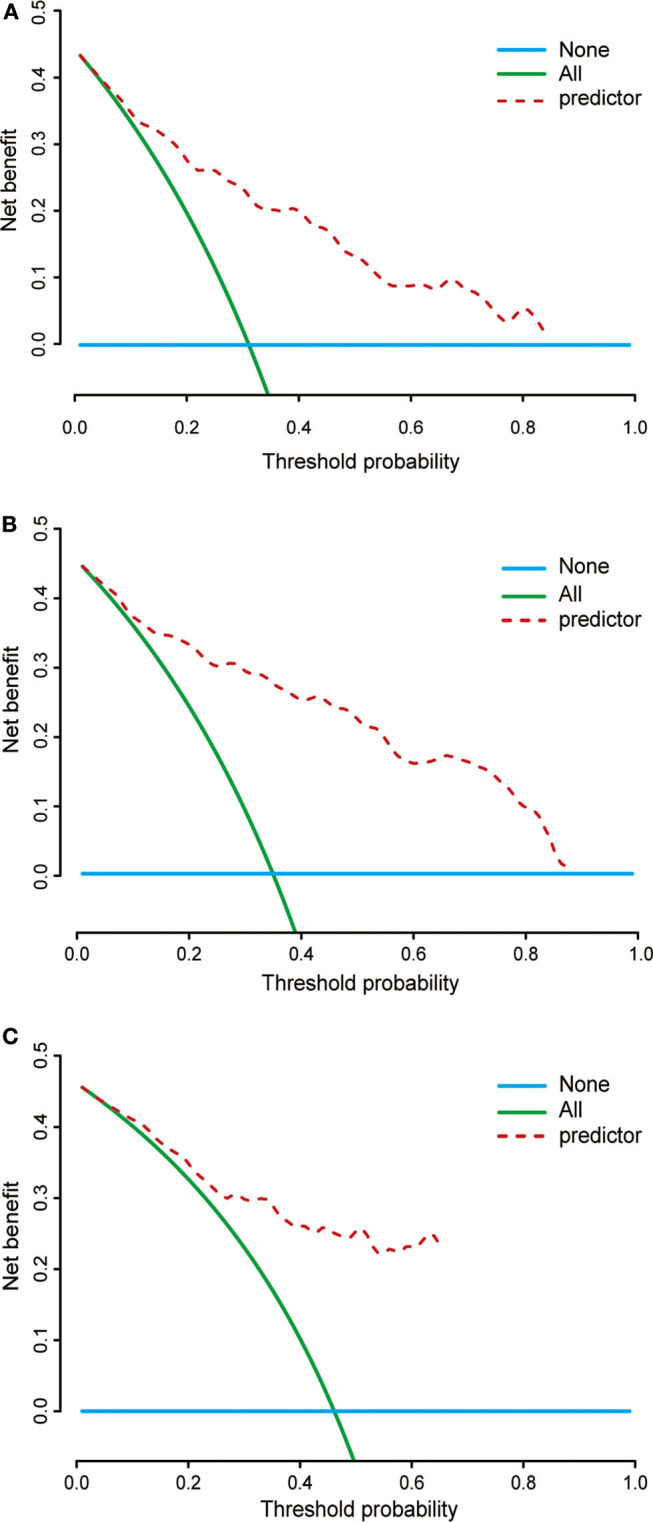
Decision curves of the nomogram predicting 36- (A), 60- (B), and 120-month (C) cancer-specific survival. The x-axis represents the threshold probability, while the y-axis indicates the net benefit calculated by adding the true positives and subtracting the false positives. The horizontal line in parallel with the x-axis assumes that cancer-specific death did not occur in any of the patients, while the solid green line assumes that all patients will have cancer-specific death at a specific threshold probability. The brown dashed line represents the net benefit of using the nomogram.